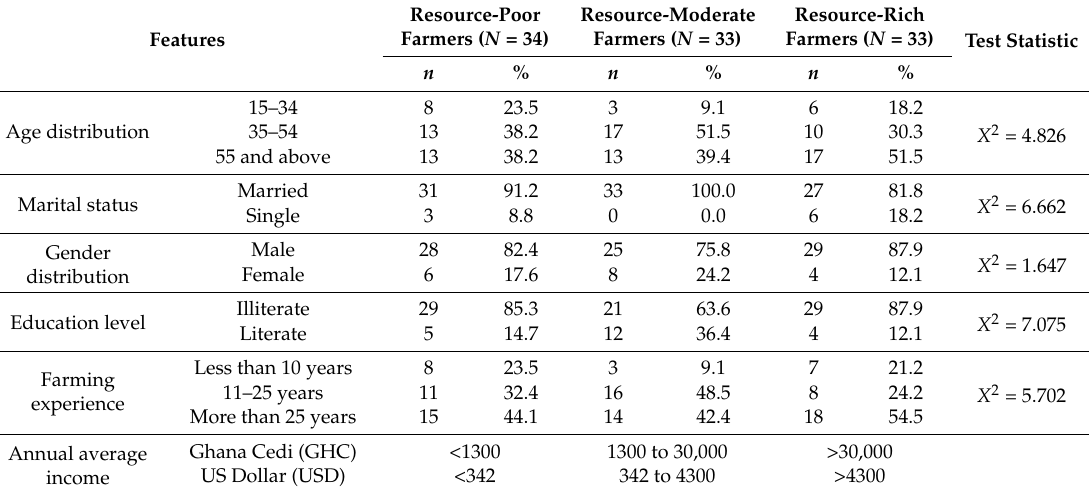
Table 4. Demographic features of respondents in Lawra district ( N = 100).